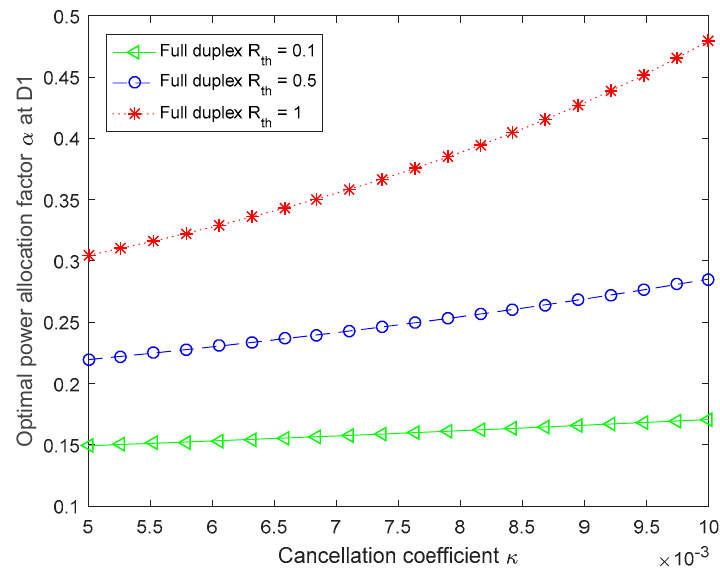
Figure 6. The optimal power allocation factor at D1 under various cancellation coefficient.